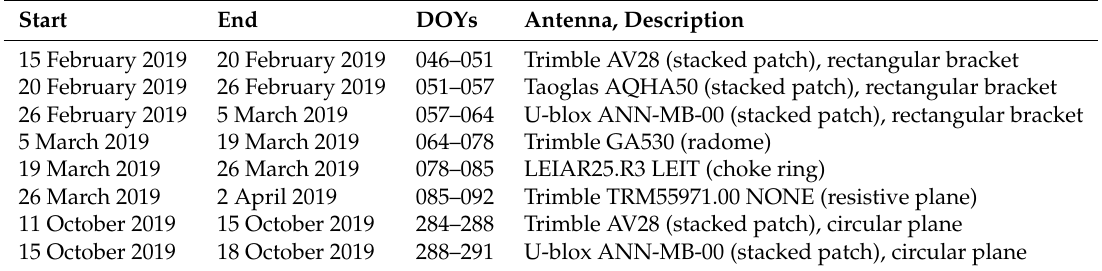
Figure 1. Waterproof pelican box rover equipment on the ground next to the marker ( a ). The pelican box contains the U-blox ZED-F9P, a Raspberry Pi Zero for data logging, power and a Septentrio receiver. The Septentrio receiver is used to provide power, through an antenna splitter, to the antennas: LEIAR25.R3 ( b ), Zephyr2 ( c ) and GA530 ( d ). No data collection or processing is performed with the Septentrio receiver. The verification setup is depicted in ( b ). It shows the baseline setup with two LEIAR25.R3 LEIT antennas. The antenna in the foreground is at the marker that is used for the investigation. In the background the radome and antenna of the base station DLF1 is visible. Both antennas are oriented North. The subfigures ( b – f ) illustrate the marker used for the investigation with different installed antennas. The antennas AV28 ( e ) and ANN-MB-00 ( f ) are depicted with a circular plane. Table 1. Time frame and antenna descriptions of the antenna placements on GPS Mark 15 for the short-baseline